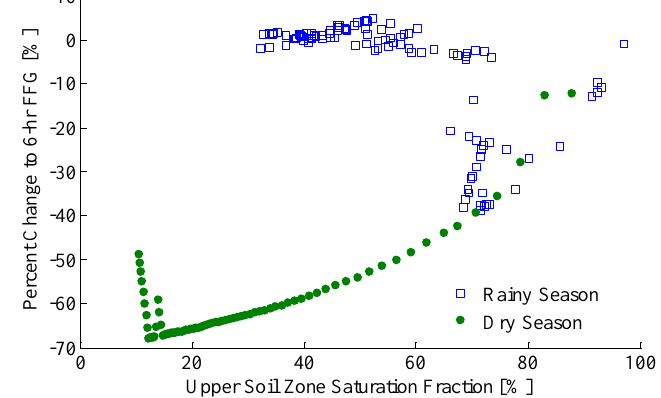
Figure 14. Impact of flood map assimilation on the results of the FFG value for Basin No. 31245, as a function of the model soil saturation fraction (with no assimilation). More negative values indicate that less water is required to declare a flash flood warning or alert.